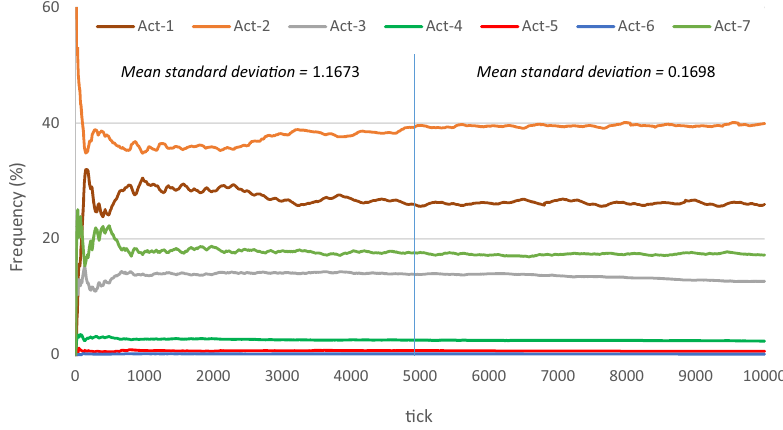
Figure 4. The frequency of executed actions, aggregated from all players in each time steps. The Y axis shows the percentage of each action executed by all players at each time step (X axis). The mean standard deviation of all actions from tick 1–5000, and from 5001 to 10000 are represented in the figure. Actions are abbreviated as follows: move randomly (Act-1), mark the nearest opponent (Act-2), get possession of the ball (Act-3), carry